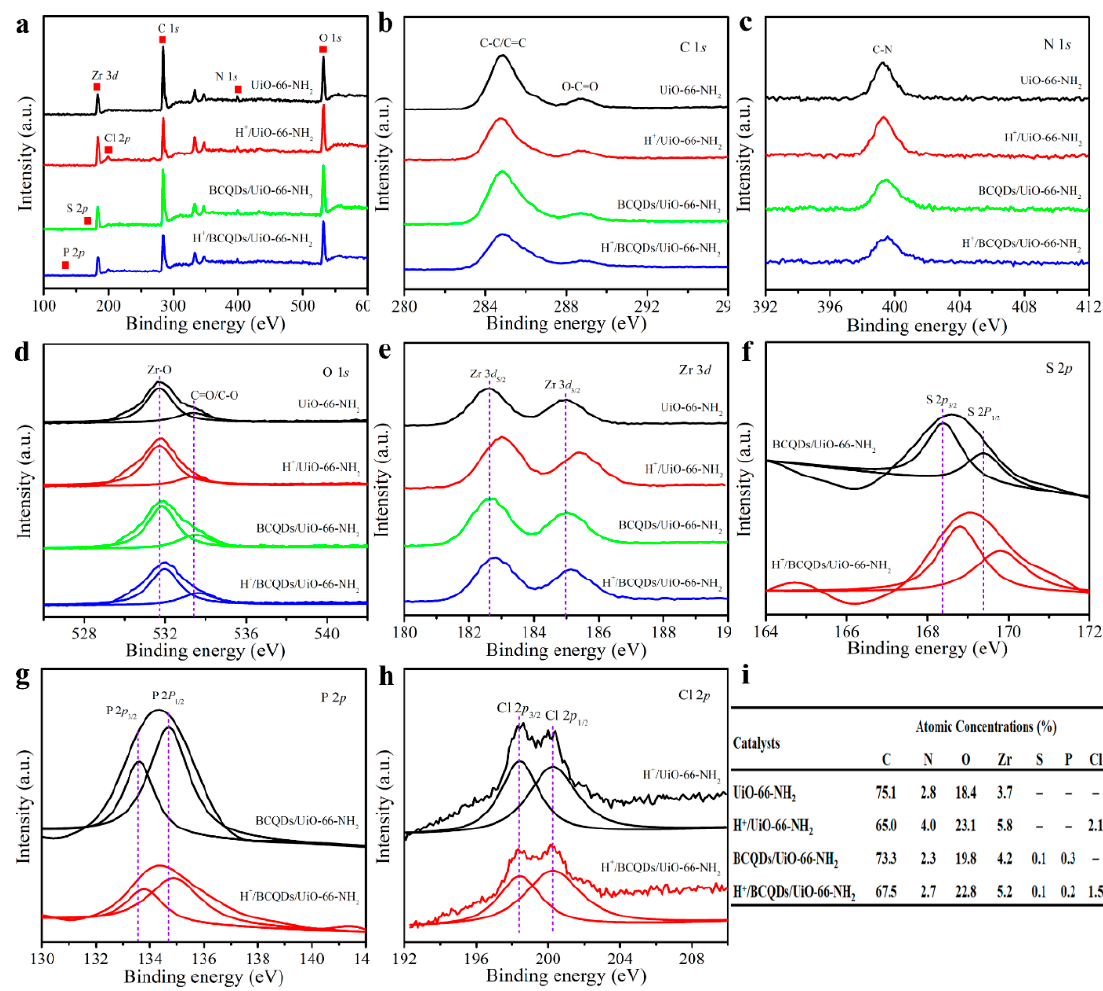
Figure 4. XPS spectra of UiO-66-NH 2 , H + /UiO-66-NH 2 , BCQDs/UiO-66-NH 2 , and H + /BCQDs/UiO- 66-NH 2 . ( a ) Survey; ( b ) C 1s; ( c ) N 1s; ( d ) O 1s; ( e ) Zr 3d; ( f ) S 2p; ( g ) P 2p; ( h ) Cl 2p, and ( i ) the corresponding elemental contents.